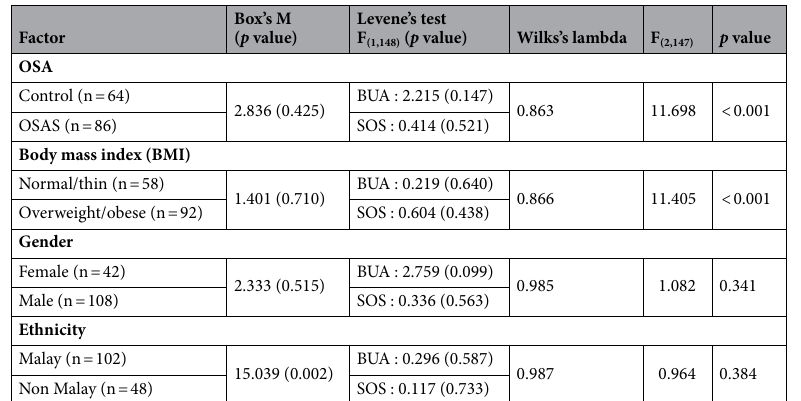
with BMI (r = − 0.248, p = < 0.01).